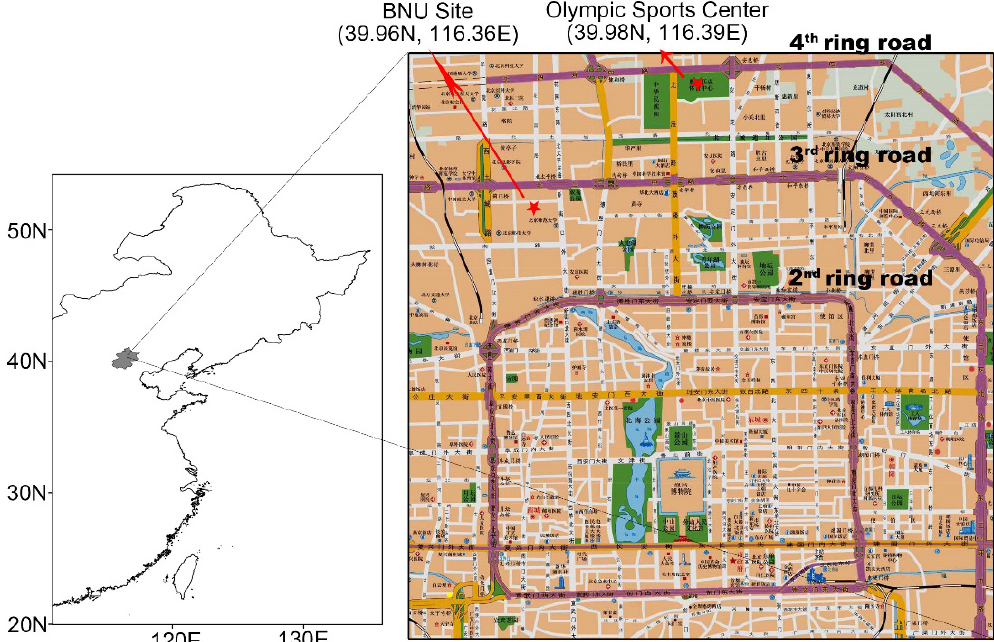
Figure 1. Observation sites in Beijing. All the data was obtained at BNU site except for gaseous pollutants, which were measured at the Olympic Sports Center by the National Environmental